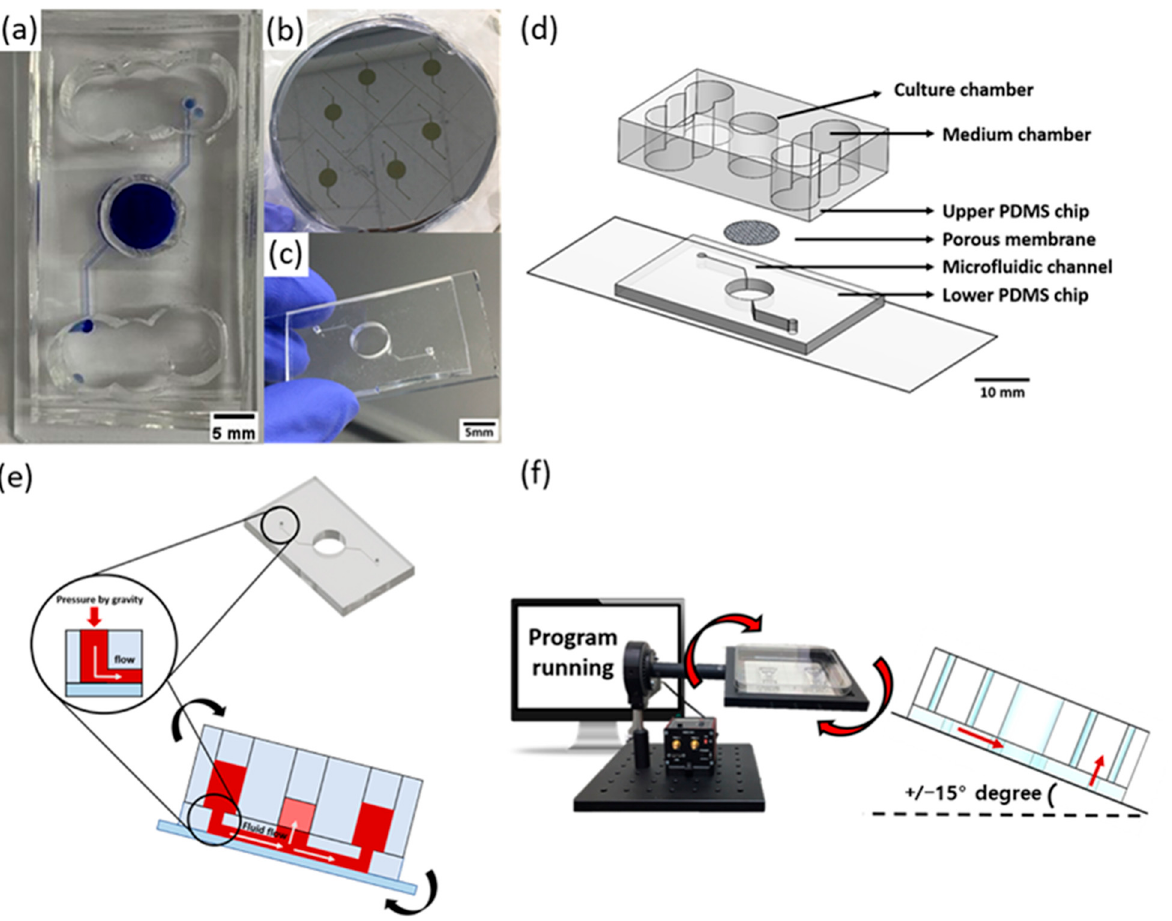
Figure 6. A schematic diagram of a microfluidic skin-on-a-chip model before assembly and a gravity flow system. ( a ) Upper PDMS chip. ( b ) Microfluidic channels patterned mask mold. ( c ) The lower chip with the microfluidic channel pattern. ( d ) Configuration diagram of pumpless microfluidic skin-on-a-chip model. ( e ) A schematic diagram of a microfluidic skin-on-a-chip model before its assembly. ( f ) Views of the front and side of the gravity flow system. It works by shaking both sides at 15° degrees. A 15° degree tilt causes the medium to circulate through the microfluidic channel [4,43].